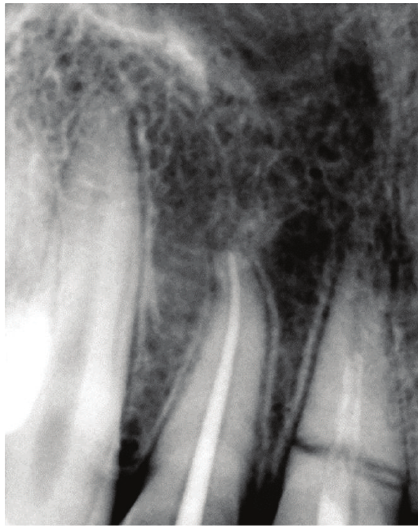
Figure 5: Master cone 12.